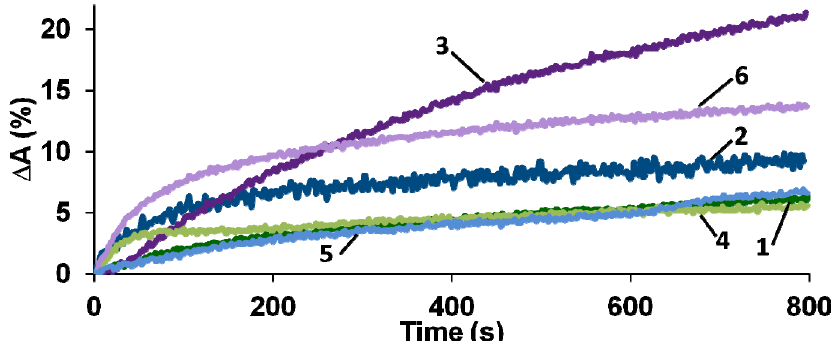
Figure 9. The response transients for PEDOT films obtained in the presence of PAMPSA (1), t-PASA (2), PAMPSA/t-PASA (1:1) (3), PAMPSNa (4), t-PASNa (5) and PAMPSNa/t-PASNa (6) exposed to 25 ppm NH 3 .